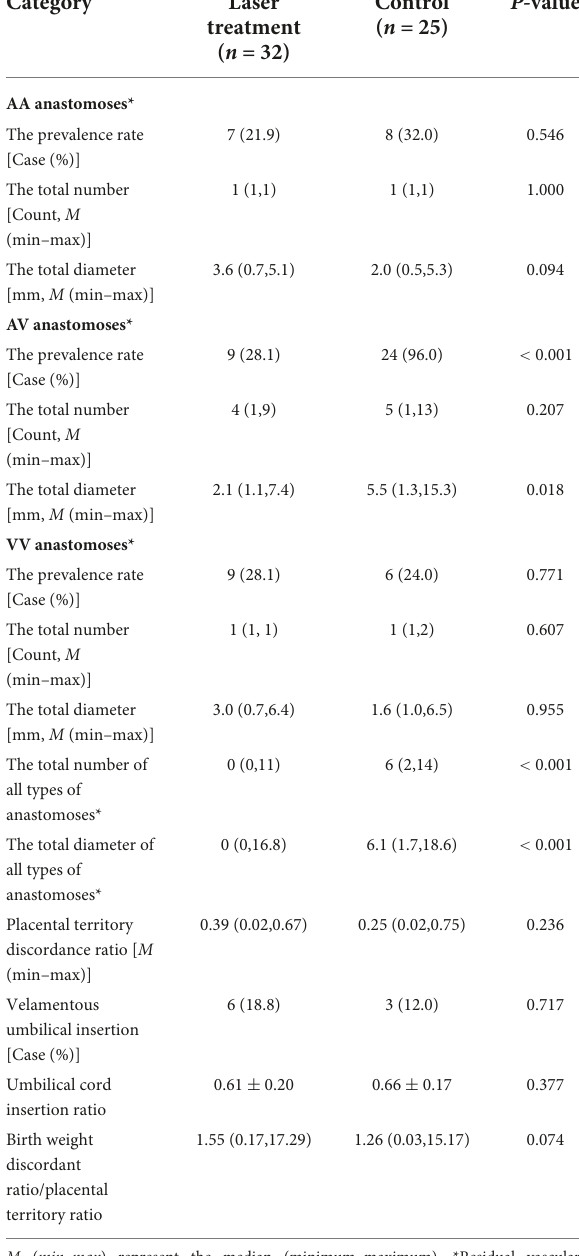
TABLE 2 The placental characteristics of TTTS patients between the two study groups.